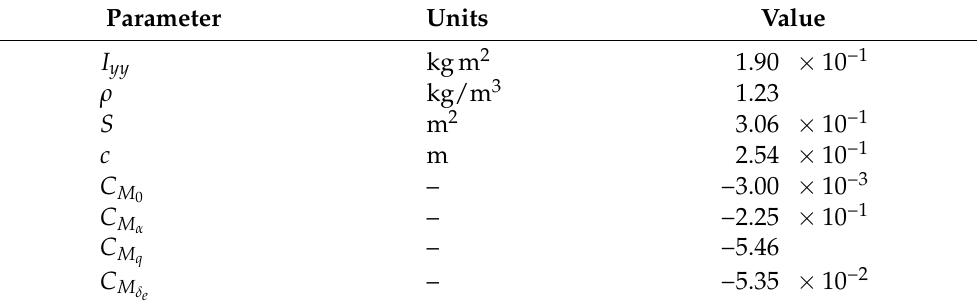
Table 1. Parameters of wind tunnel